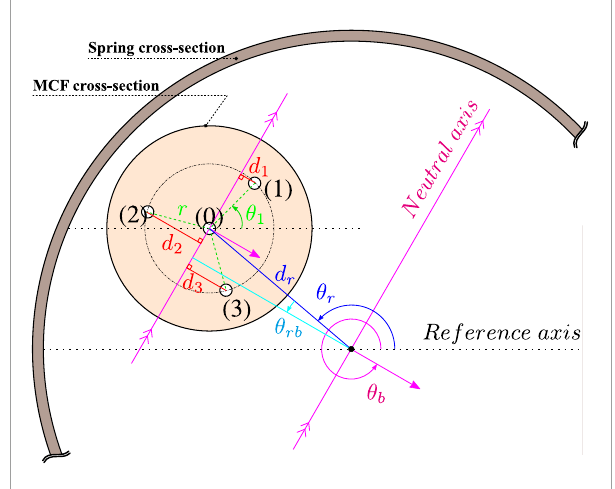
FIGURE 4 Cross-sectional view of the MCF and spring combination. The MCF’s center is at a radial offset d r from the spring’s center and at an angular offset θ r with respect to a reference axis. θ b is the angle of the bending plane vector with respect to the reference axis and θ 1 is the angle between the center of the first outer core and the reference axis. r is the radial distance from an outer core to the central core, and d i for i ∈ [ 1 , 2 , 3 ] is the perpendicular distance between the outer cores and the neutral axis crossing the central core. θ rb is the angle between the bending plane vector θ b − π and θ r